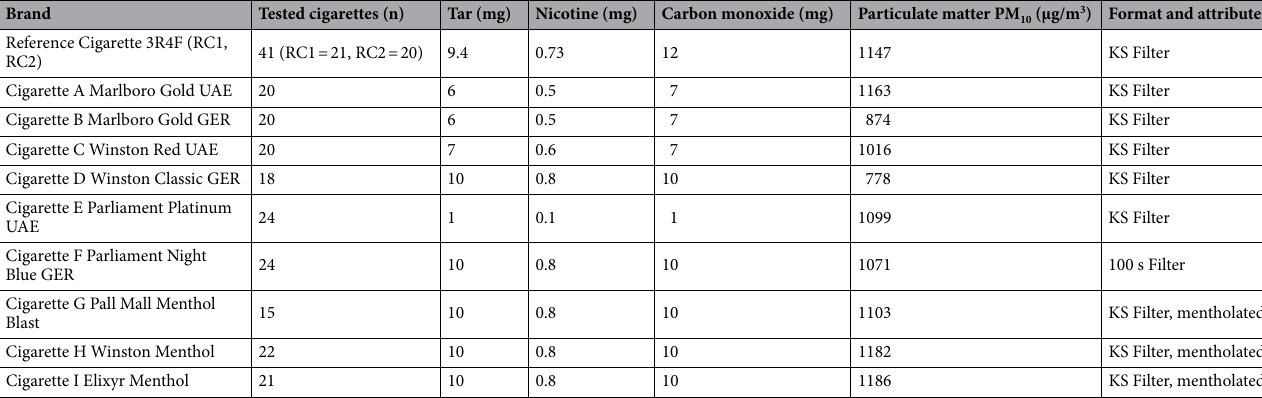
Table 1. Features of the tested cigarette brands. Data on particulate matter (PM 10 ) are measured mean concentrations. PM 10 data of the reference cigarette RC1 and the cigarette brands G, H, and I were adjusted on the PM 10 data of the reference cigarette RC2 by statistical data transformation. Information on the reference cigarette is taken from the manufacturer (Kentucky Tobacco Research and Development Center of the University of Kentucky). Information on the cigarettes A to I as specified by the manufacturers. KS King Size, UAE United Arab Emirates, GER